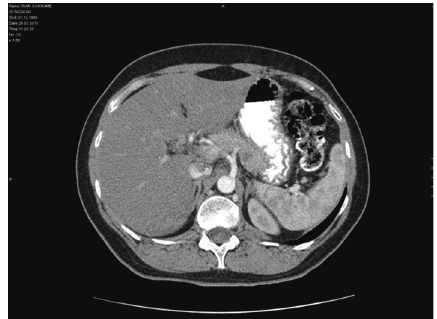
Figure 2: Abdominal CT shows a 4 × 2 cm-sized cystic lesion in mid portion of pancreas.